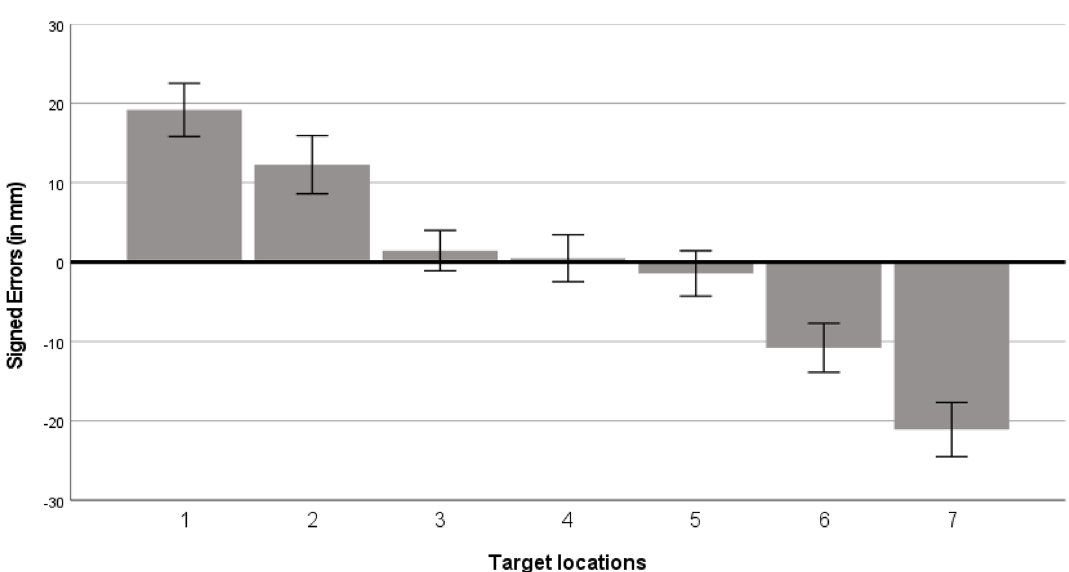
Figure 2. Participants’ horizontal signed errors (in mm) for different target locations, collapsed across the scaling factors. Target locations on the X-coordinate accorded to: 1 = 17.5 mm, 2 = 40 mm, 3 = 62.5 mm, 4 = 85 mm, 5 = 107.5 mm, 6 = 130 mm, 7 = 152.5 mm. Error bars represent ± 1 standard error. Positive signed errors indicate answers located too far to the right; negative signed errors indicate answers located too far to the left on the referent